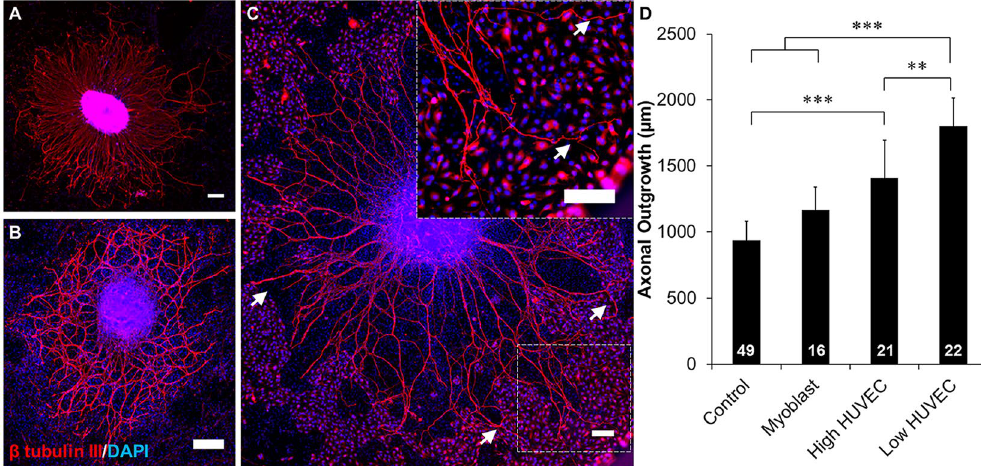
Figure 1. HUVEC enhanced DRG axonal growth is cell type specific. DRG explants cultured on ( A ) poly- D-lysine (PDL) coated wells, ( B ) myoblasts, and ( C ) HUVECs. PDL and myoblast coatings facilitated axonal growth that was radially symmetrical while HUVEC co-cultures facilitated asymmetric growth towards clusters of HUVECs (arrows). Scale = 200 µ m. ( D ) Quantification of axonal growth from DRG explants on different surfaces. Low density of HUVECs supported the most axonal outgrowth of all treatment groups. Data are presented as mean ± standard error. * (p < 0.05), ** (p < 0.01), *** (p < 0.001) and brackets indicate significance from other surfaces as determined by one-way ANOVA with Holm-Sidak post hoc analysis (DRG sample size for each group shown in bars from 3 independent